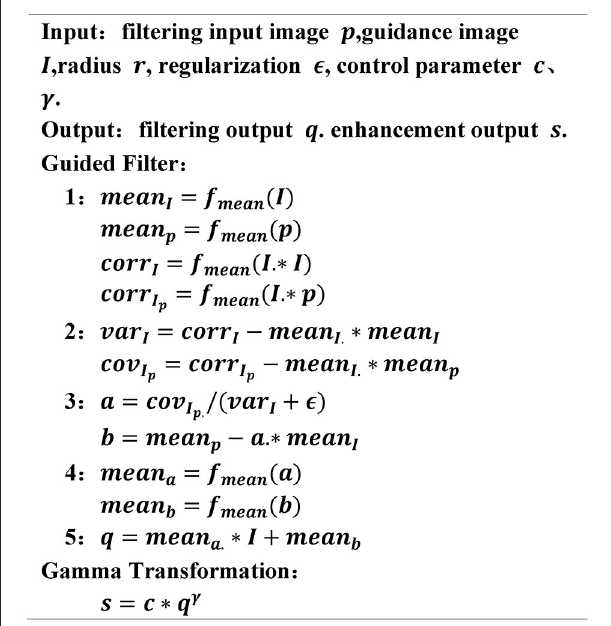
FIGURE 2 | The pseudocode of denoising and enhancement algorithms.